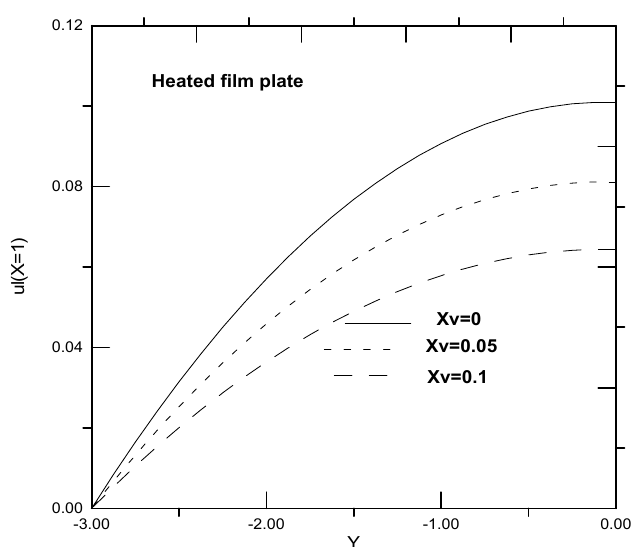
ff ect of the nanoparticle volume rate on the film velocity – heated plate Figure 7. Effect of the nanoparticle volume rate on the film velocity – heated plate case. Figure 7. E